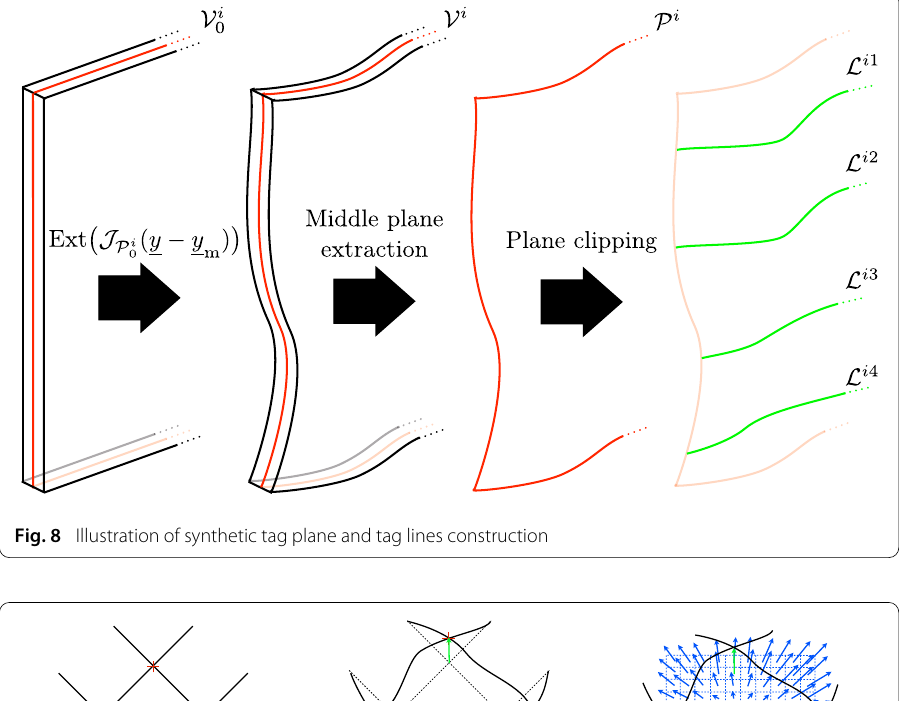
Fig. 8 Illustration of synthetic tag plane and tag lines construction